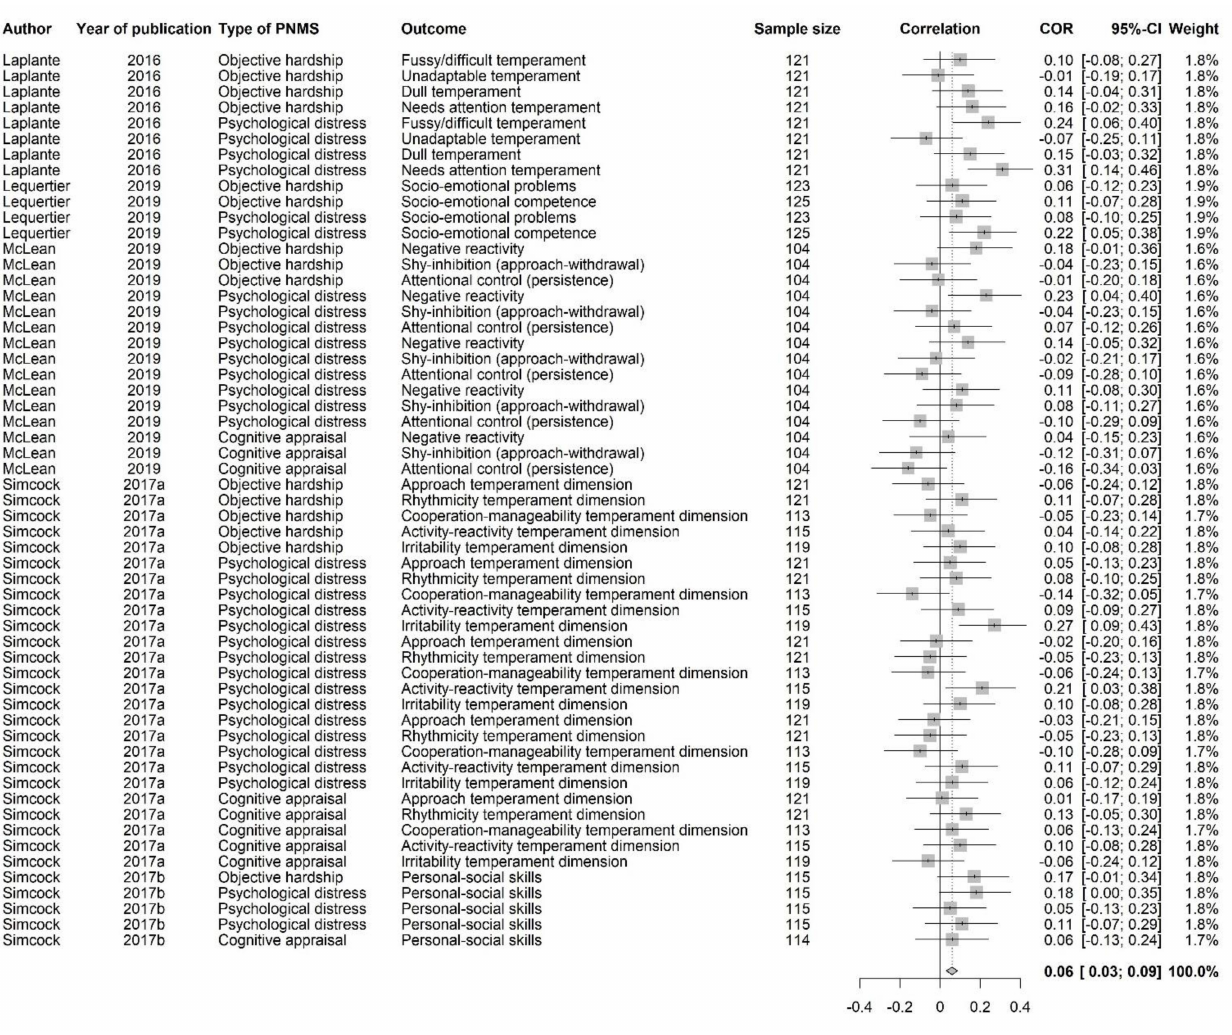
Figure 14. Socio-emotional outcomes forest